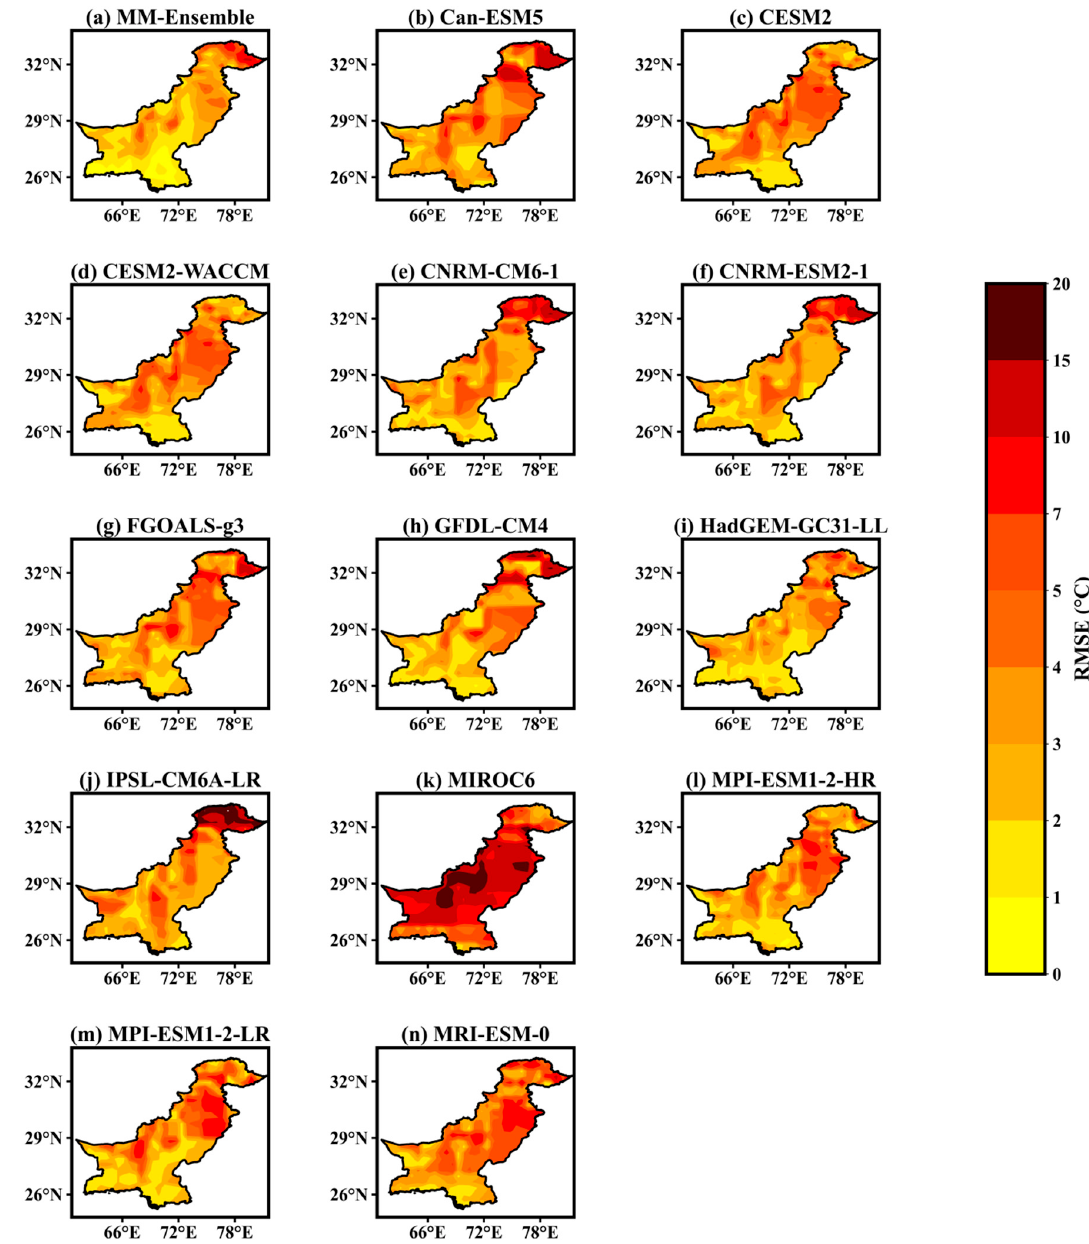
Figure 11. Spatial RMSE distribution of JJA mean temperature ( °C ) over Pakistan for 1970–2014 by ( a ) MM-Ensemble, ( b ) Can-ESM5, ( c ) CESM2, ( d ) CESM-WACCM, ( e ) CNRM-CM6-1, ( f ) CNRM-ESM2-1, ( g ) FGOALS-g3, ( h ) GFDL-CM4, ( i ) HadGEM-GC31-LL, ( j ) IPSL-CM6A-LR, ( k ) MIROC6, ( l ) MPI-ESM1-2-HR, ( m ) MPI-ESM-2-LR, and ( n ) MRI-ESM-0.